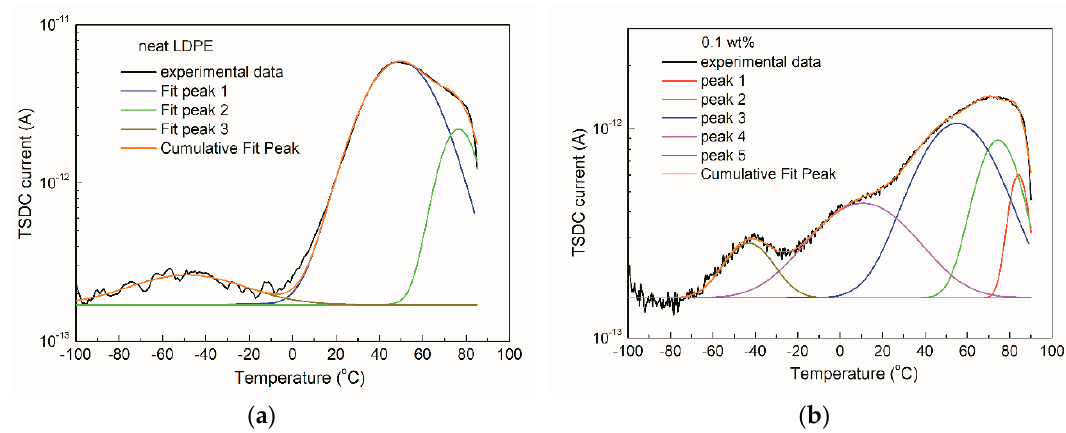
Figure 6. Fitting results of LDPE / TiO 2 nanocomposites, indicating the multi-relaxation processes in the nanocomposites. ( a ) Neat LDPE; ( b ) 0.1 wt%.